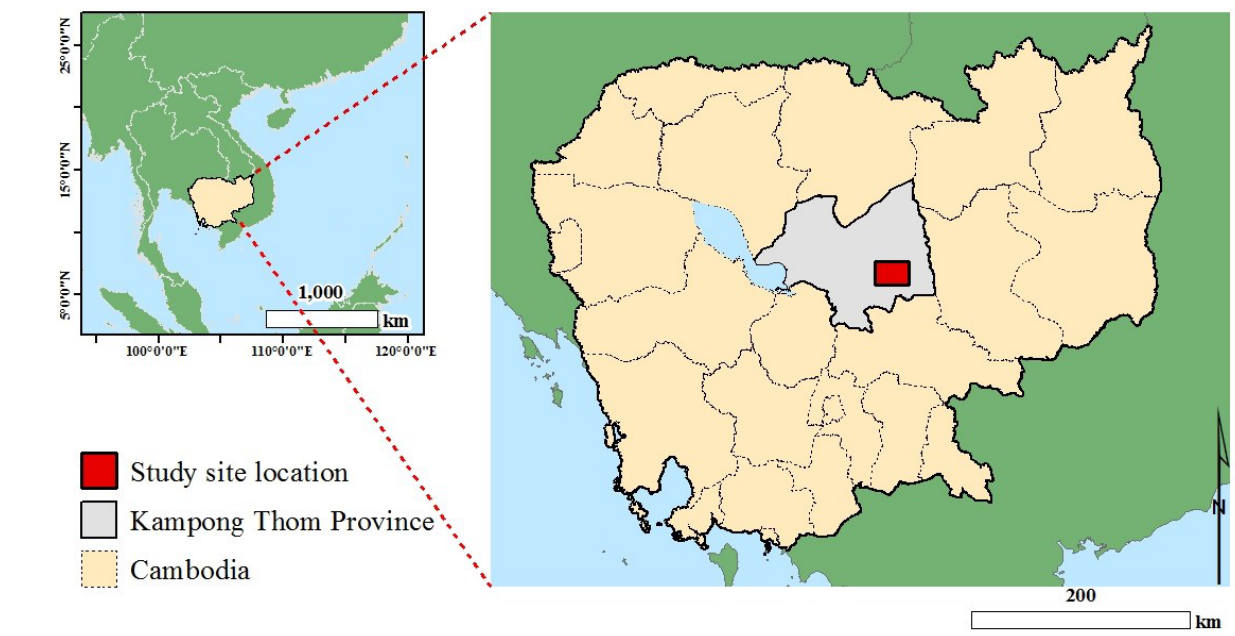
Figure 1. Study area in Kampong Thom Province, Cambodia with an inset map showing the study site location within extreme Southeast